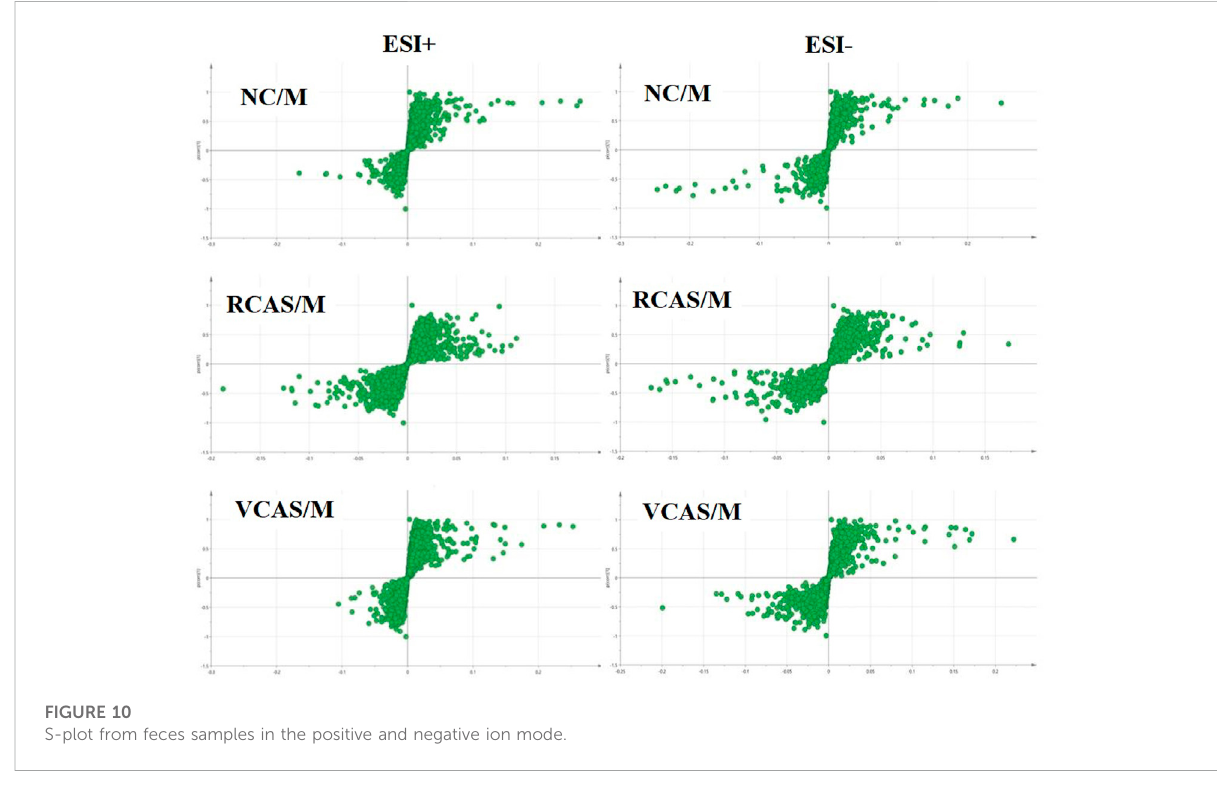
FIGURE 10 S-plot from feces samples in the positive and negative ion mode.